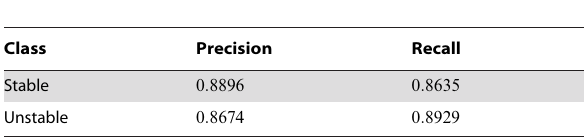
Table 2. Classifier